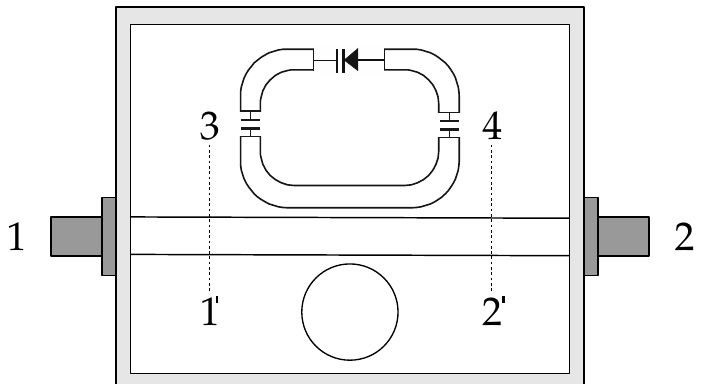
Figure 10. Schematic representation of the de-embedding procedure with port definition for the in- trinsic band-stop filter: EM simulation